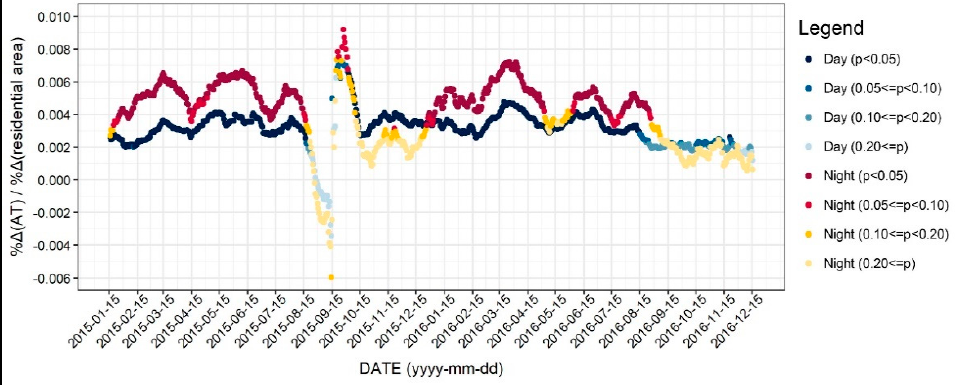
Figure 8. Changing patterns in the regression coefficients and their significances (surface albedo). Figure 9. Changing patterns in the regression coefficients and their significances (residential use). Figure 9. Changing patterns in the regression coe ffi cients and their significances (residential